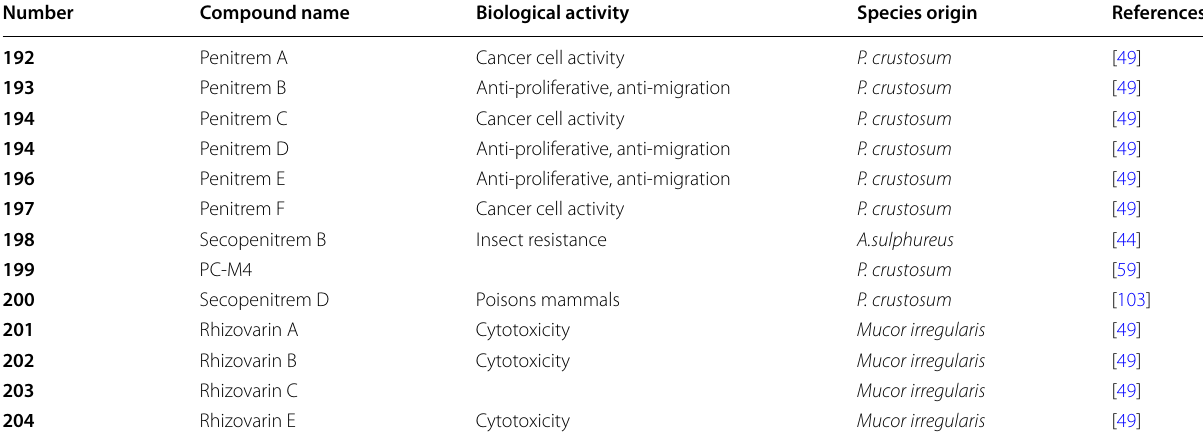
Table 13 Name, bioactivities and source of compounds with A‑ring 4/5 or 6 membered